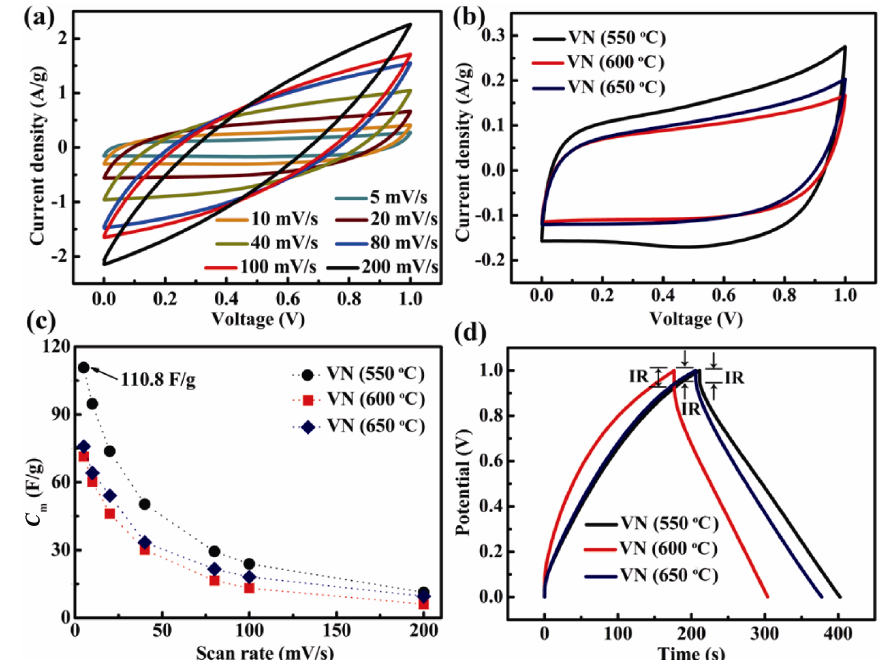
Fig. 6 (a) CV curves of VN nanofibers nitrided at 550 ℃ tested at various scan rate from 5 to 200 mV/s; (b) CV curves of all the samples at a scan rate of 5 mV/s; (c) C m of these three samples plotted as a function of scan rate; (d) GDC curves collected from all the samples at 0.1